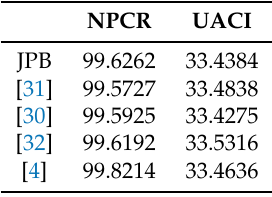
Table 5. NPCR and UACI of Lena using different algorithms.